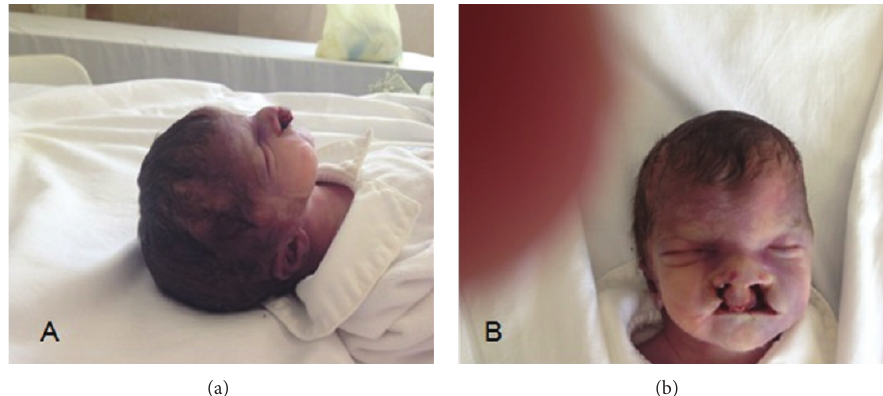
Figure 3: Phenotypical features of the affected newborn included a broad nasal bridge (a) and hypertelorism bilateral cleft lip and palate (b).